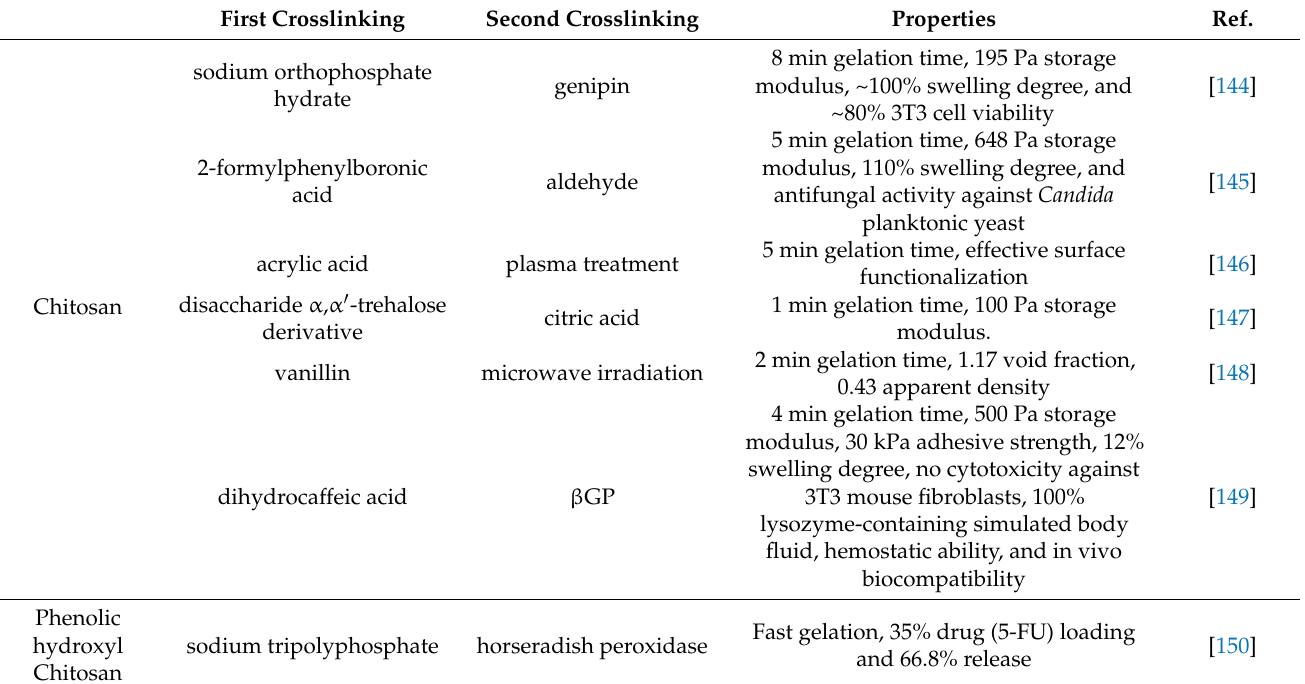
Table 1. Dual crosslinking of hydrogels, prepared from chitosan and chitosan derivatives, and the resultant